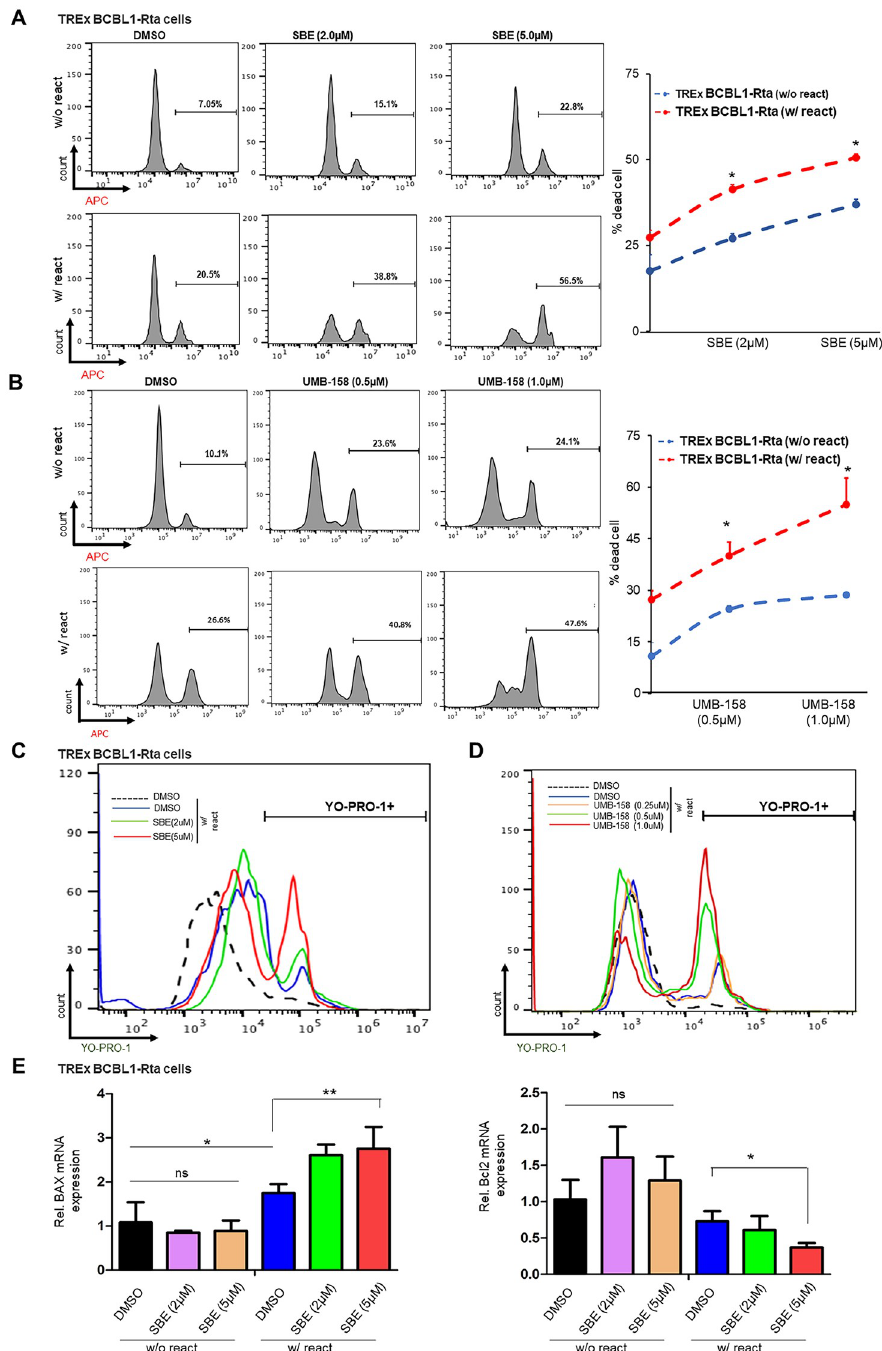
Fig 3. PLK1 inhibition promotes death of KSHV-reactivated cells. (A, B) TREx BCBL1-Rta cells were treated with SBE (A), UMB-158 (B), or DMSO, in the presence or absence of Dox to induce KSHV reactivation. Percentage of dead cells was measured by LIVE/DEAD staining, followed by flow cytometry analysis. (C, D) TREx BCBL1-Rta cells were treated with SBE (C), UMB-158 (D), or DMSO, and induced with Dox. Percentage of apoptotic cells was measured by YO-PRO-1 staining, followed by flow cytometry analysis. (E) mRNA level of apoptosis-related genes, BAX and Bcl2, in TREx BCBL1-Rta cells +/- SBE and +/- Dox were measured by RT-qPCR and normalized to GAPDH. Results were calculated from n = 3 independent experiments and presented as mean ± SD (ns: not significant, � p < 0.05, �� p < 0.01; two-tailed paired Student t-test).